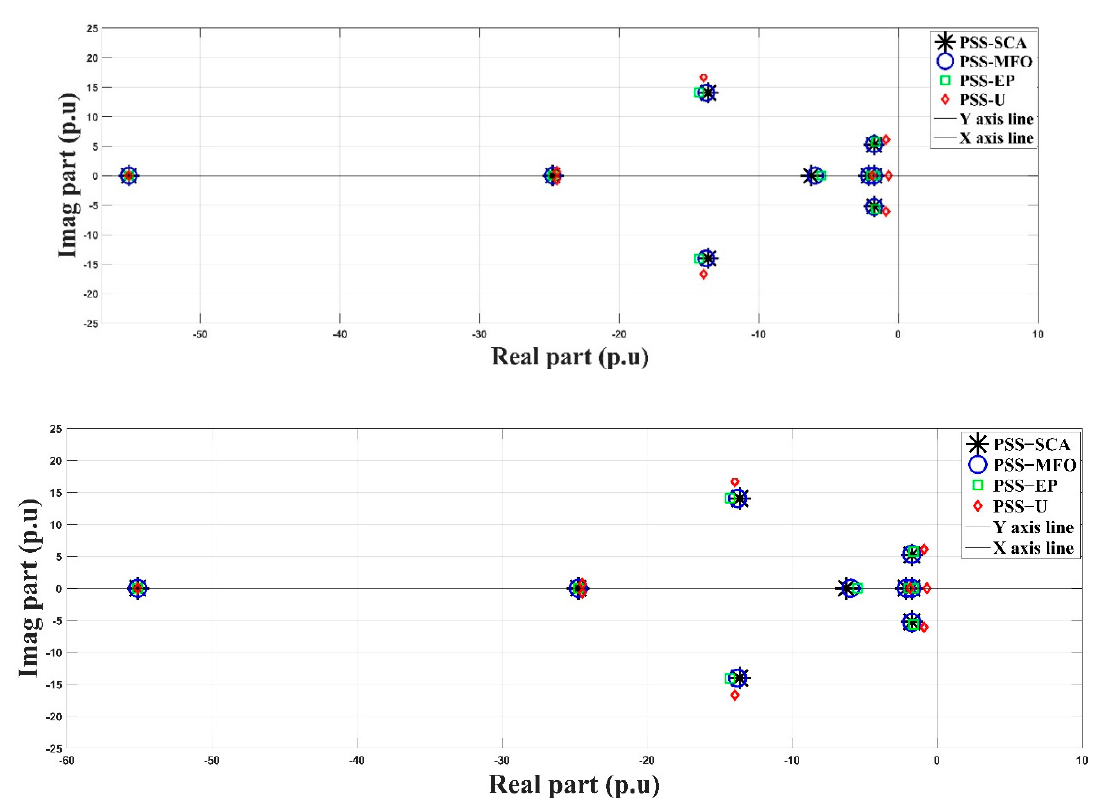
Figure 9. Rotor angle deviation response of PSS-SCA, PSS-MFO, PSS-EP, and PSS-U for case 2.